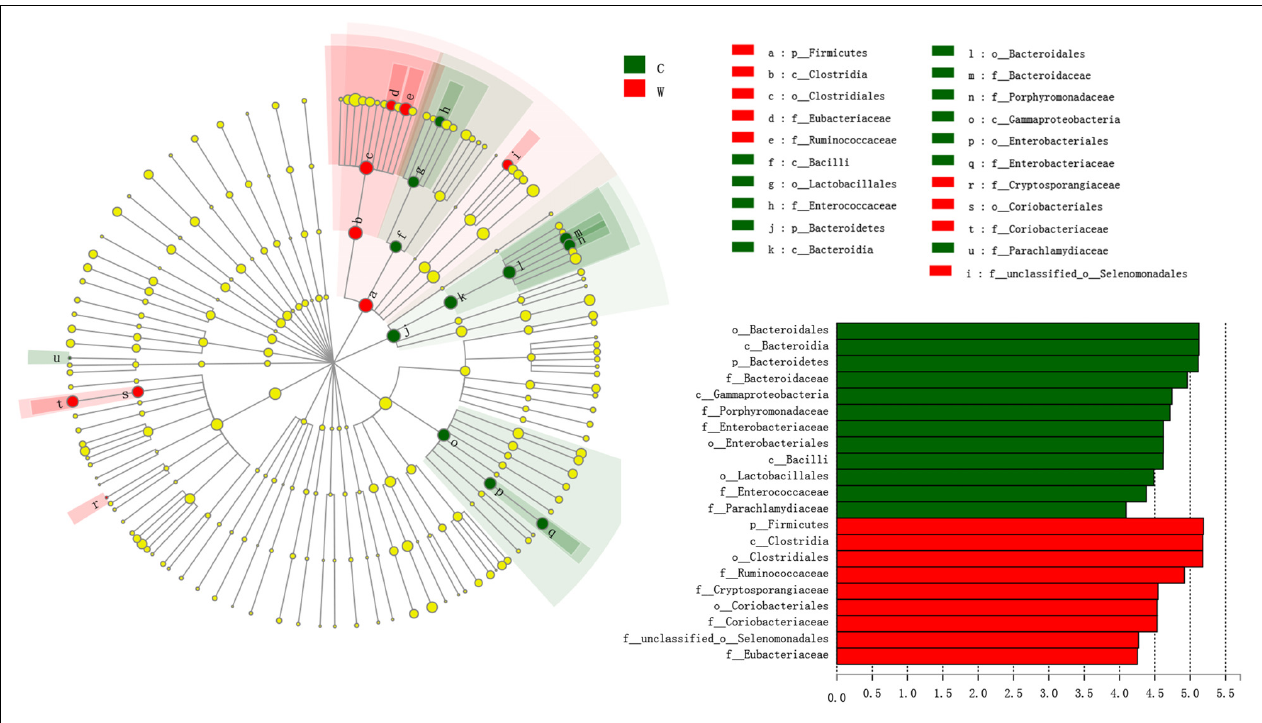
FIGURE 4 | Family, order, class and phyla that were differentially represented between captive groups and wild groups, as indicated by relative abundances based on linear discriminant analysis effect size (LEfSe) analysis linear discriminant analysis (LDA > 4, P < 0.05). Red boxes and green boxes represent enrichment in the W (wild) and C (captive) groups, respectively. Each circle’s diameter is proportional to the taxon’s abundance. The strategy of multiclass analysis is non-strict (at least one class differential). Circles represent taxonomic ranks from domain to family, from the inside to the outside. Circles represent taxonomic ranks from phylum to genus, from the inside to the outside. Labels are shown at the class, order and family levels. The scores are shown for all taxa with an LDA score > 4.